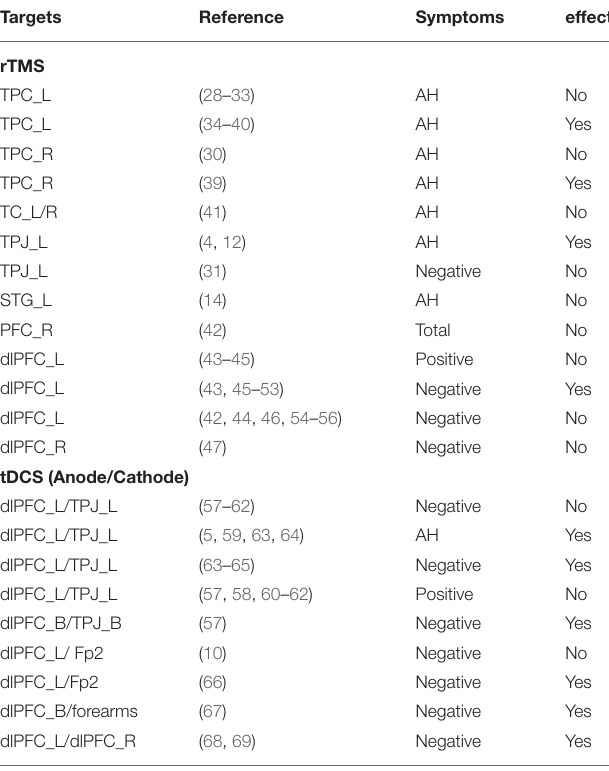
TABLE 3 | The targets used in prior studies.